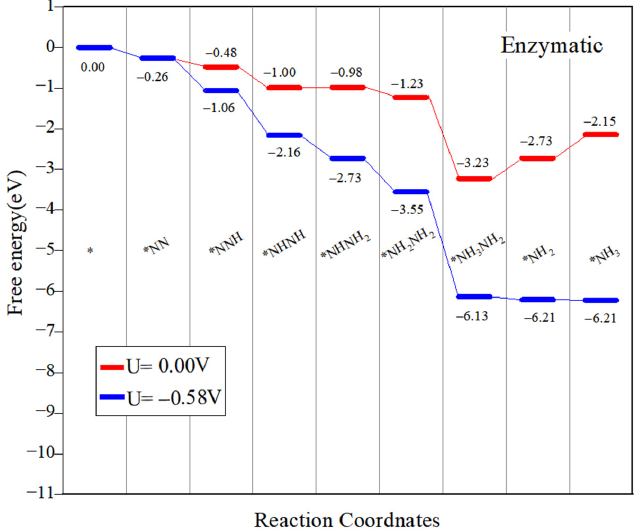
difficulty on B2@C 3 N 4 .